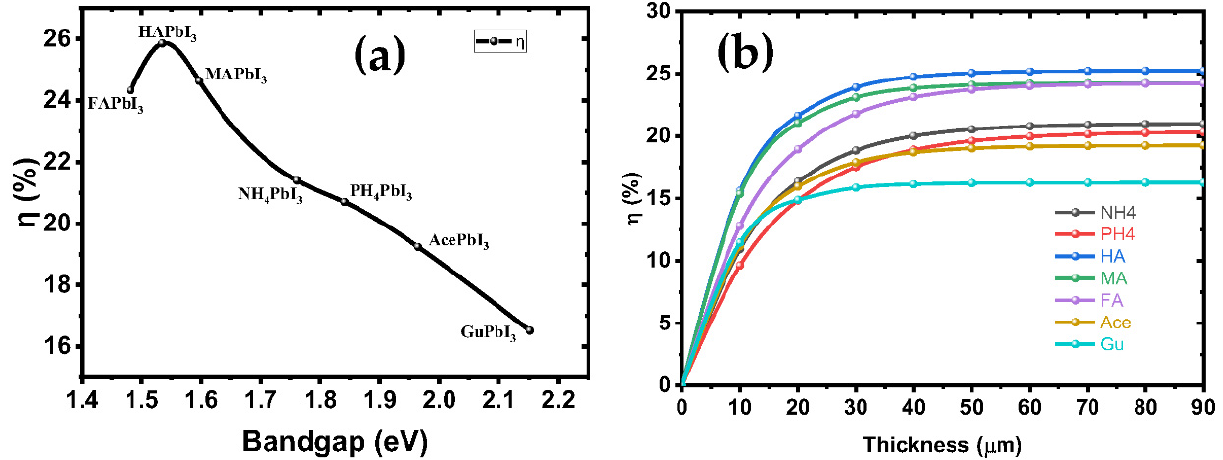
Figure 9. ( a ) The variation theoretical efficiencies under AM1.5 illumination in dependence of the bandgap energy according to the substitution of cation in A-site; and ( b ) the variation in efficiencies function in thickness of all structures.